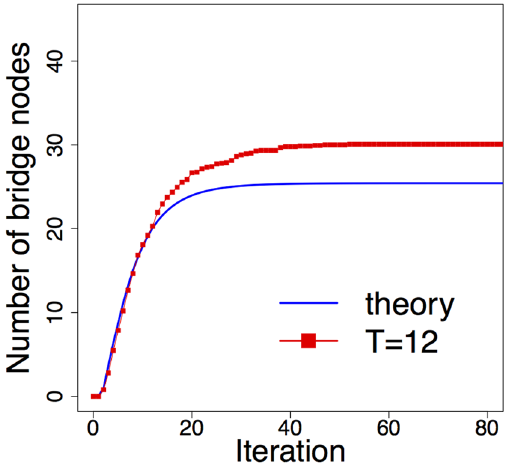
Figure 3. The recursively estimated number of bridge nodes in each iteration is plotted with the simulated values. The T = 12 line shows the average of 15 simulation runs.